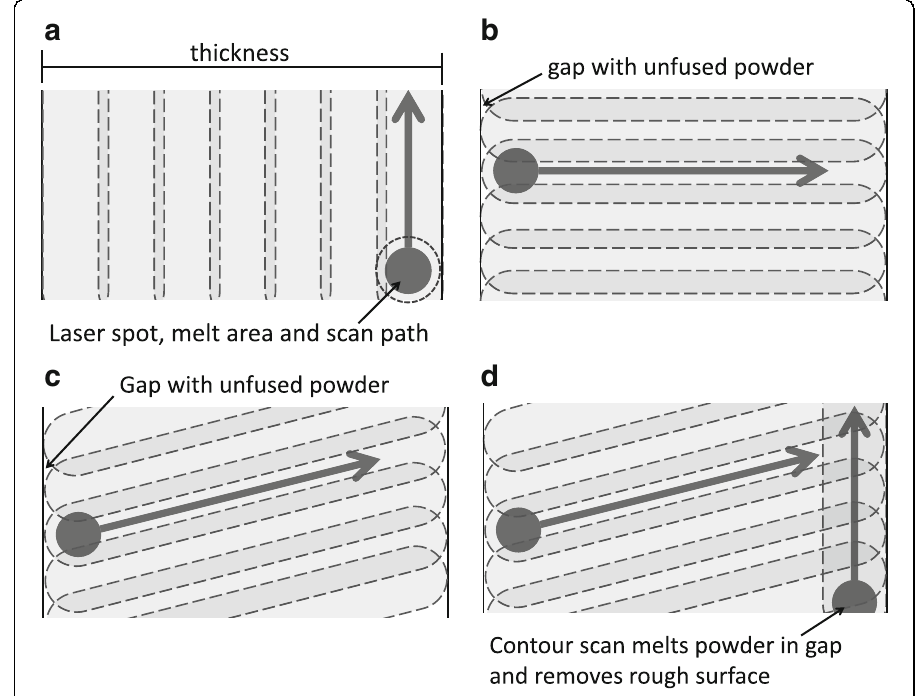
Fig. 14 Schematic illustration of scan strategies, showing laser spot, melt area, path direction and overlap. a Scan path is perpendicular to object face. b Scan path is parallel to object face. c Scan path is angled from object face. d Scan path is angled with the addition of contour scan around periphery of